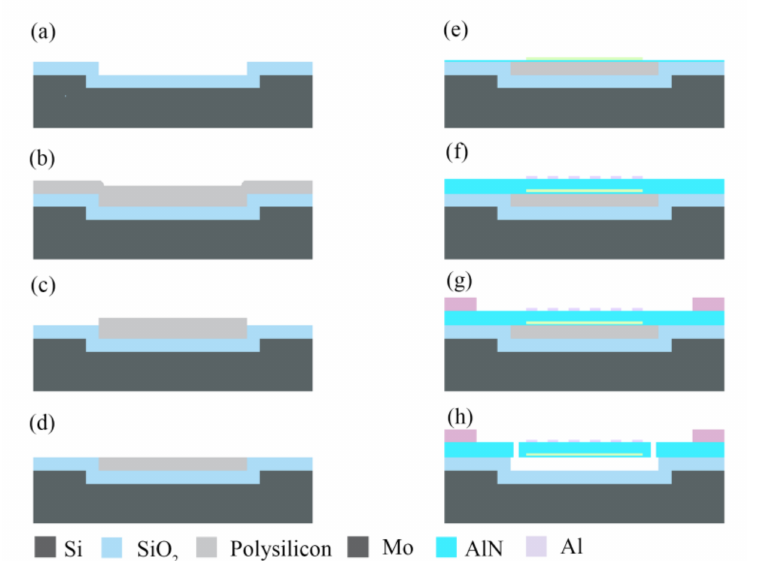
Figure 3. The fabrication process of the AlN LWRs: ( a ) silicon etching and thermal oxidation; ( b ) polysilicon deposition; ( c ) polysilicon etching; ( d ) polysilicon CMP; ( e ) AlN seed layer and Mo deposition, then Mo etching; ( f ) AlN deposition, and top IDTs formation; ( g ) Al Pads formation; ( h ) AlN etching and XeF 2